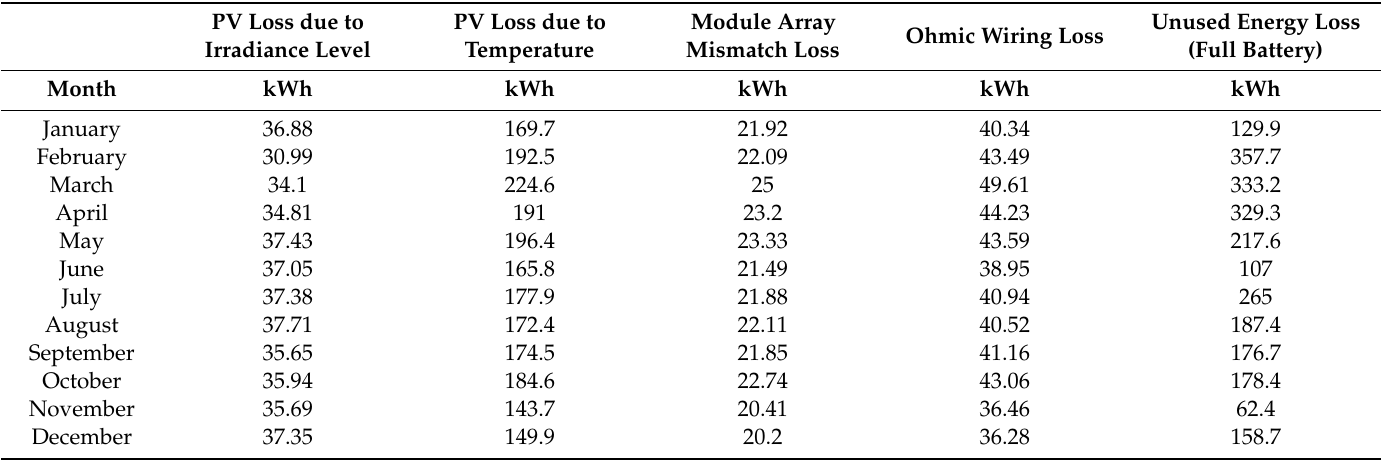
Table 3. Losses during photovoltaic (PV) energy